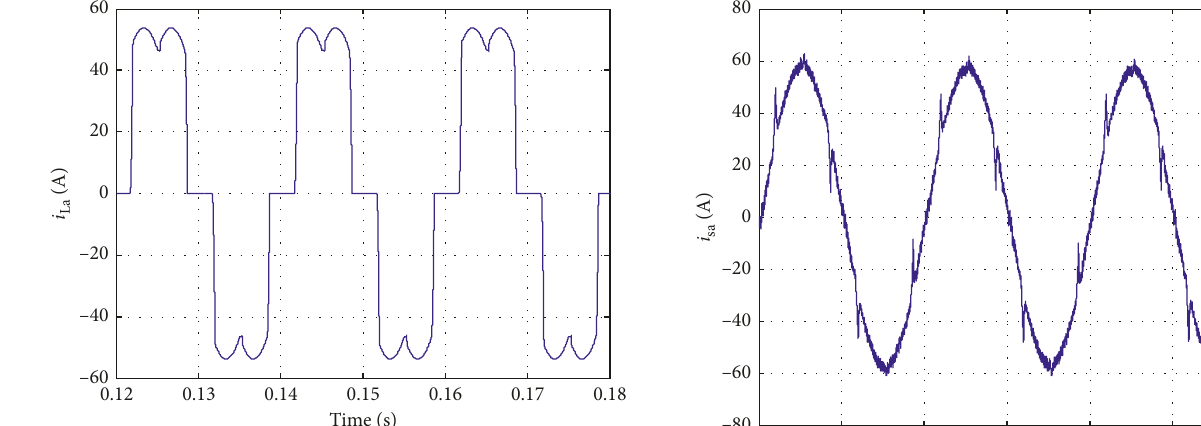
Figure 10: Waveform of nonlinear load